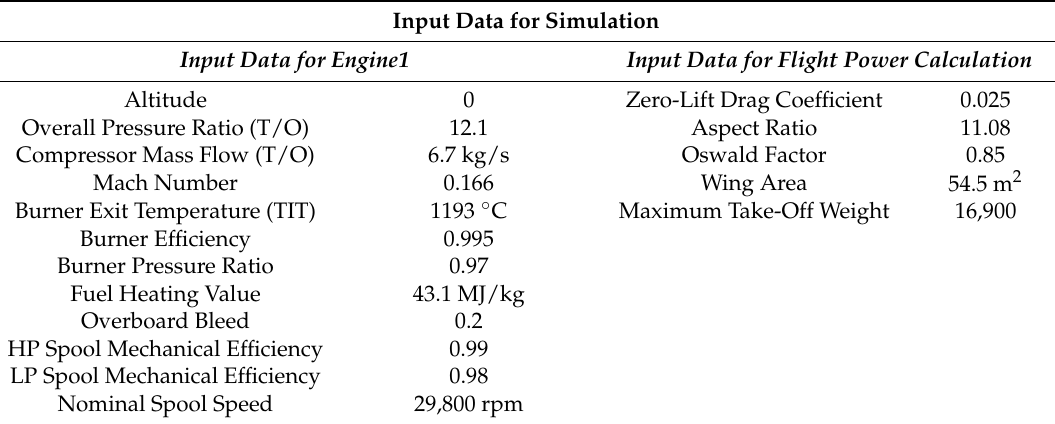
Table 2. Input data for simulation of the “Engine1 at design point” and of the “power flight profile”.